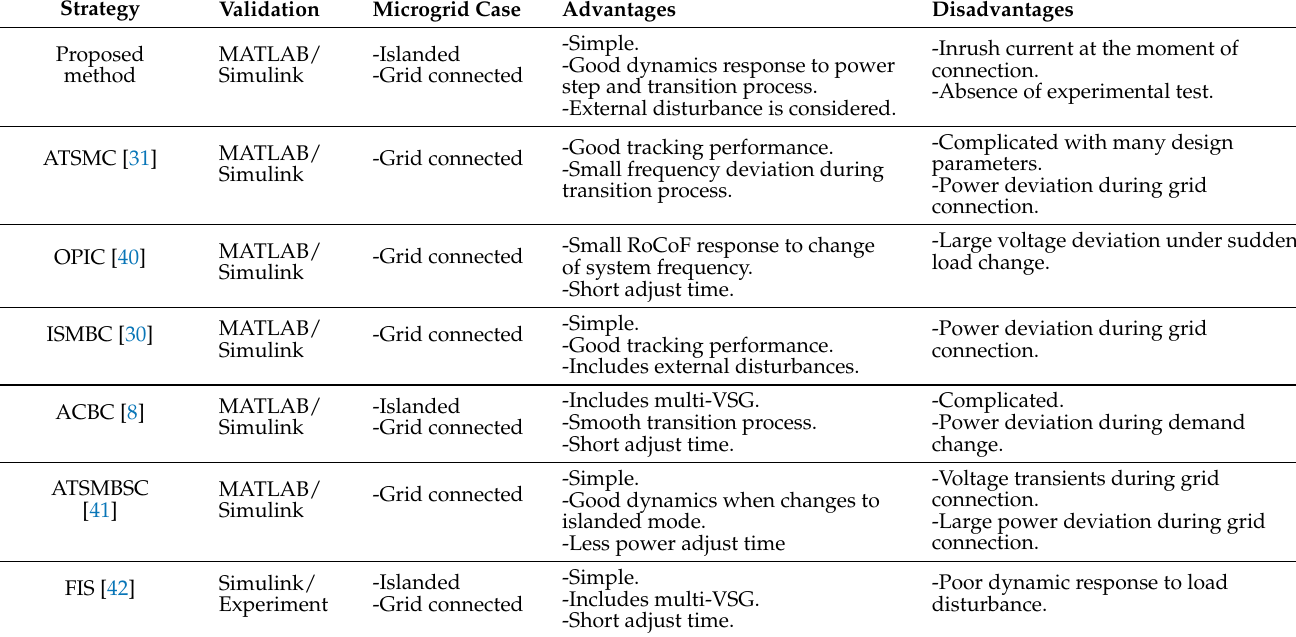
Table 3. Comparison of various VSG strategies for stability improvement with the proposed